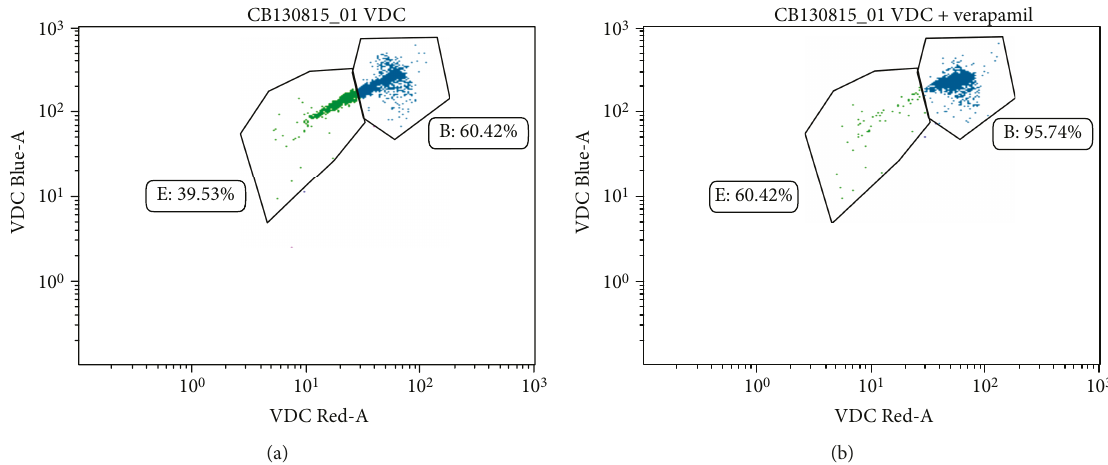
Figure 1: Representation of the SP in fl ow cytometric dot plots. (a) Dot plot showing the fl uorescence pattern of hematopoietic stem and progenitor cells (HSPCs) freshly isolated from the umbilical cord blood that has been stained and incubated with the fl uorescent dye VDC Violet. The main population of cells (gate B) shows greater fl uorescence intensity than the cells in the tail (gate E). This tail is known as the SP and represents a subpopulation of cell with greater e ffl ux ability than the rest of the cells. (b) Dot plot showing the disappearance of the SP tail when HSPCs are incubated with VDC Violet and the ABC transporter blocker, verapamil. Cells that were part of gate E have now moved up to join the main population of cells. This is due to the blocking e ff ect of verapamil, which prevents the dye from being e ffl uxed by the